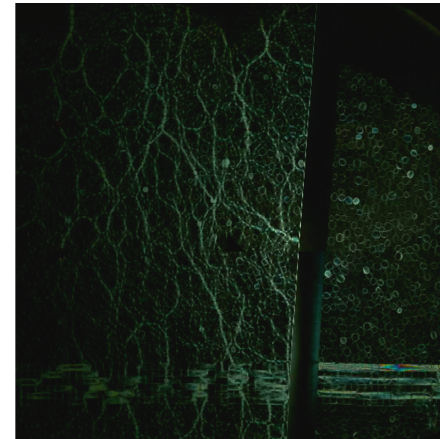
Figure 8: Force chains after the second